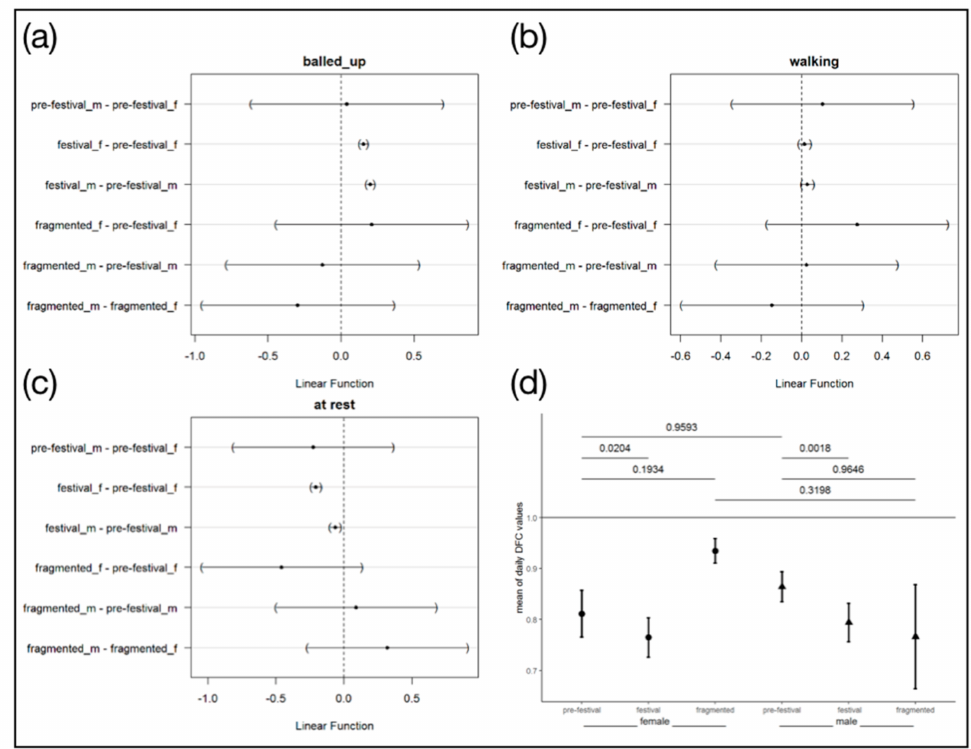
Figure 3. Behaviour parameters in the context of transient and fragmentation habitat changes. Mean values with 95% confidence interval for di ff erences in behaviour parameter counts of balling up ( a ), locomotion ( b ) and immobile behaviour ( c ) of female (f) and male (m) hedgehogs for the di ff erent study phases. The di ff erence represents changes in behaviour event counts. Negative values represent a decrease in the behaviour counts while positive values represent an increase. We considered all di ff erences to be significant where the confidence interval does not include 0 (dashed line); ( d ) Mean degrees of functional coupling for each study period and sex (1 means maximal synchrony animal’s between behaviour and the environmental 24 h period, 0 means no synchrony), whiskers = 95% family-wise confident